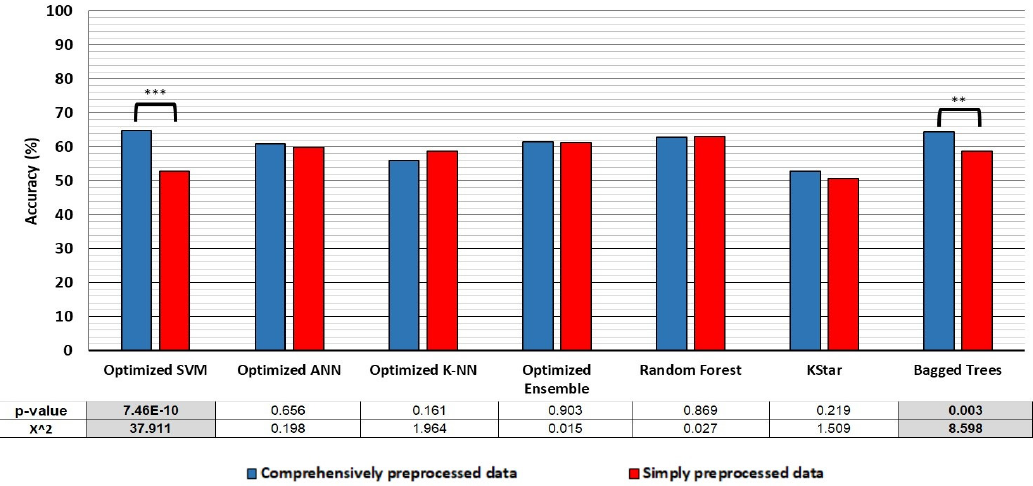
Figure 3. The performance of the seven models that achieved over 95% accuracy in the 10-fold cross validation testing in classification of the withheld comprehensively and simply processed datasets. The emboldened and grayed values in the table under the graph show statistically significantly different performances of a model on the two datasets. The *** symbol denotes statistical significance at the level of p < 0.001, while the ** symbol denotes statistical significance at the level of p < 0.01.